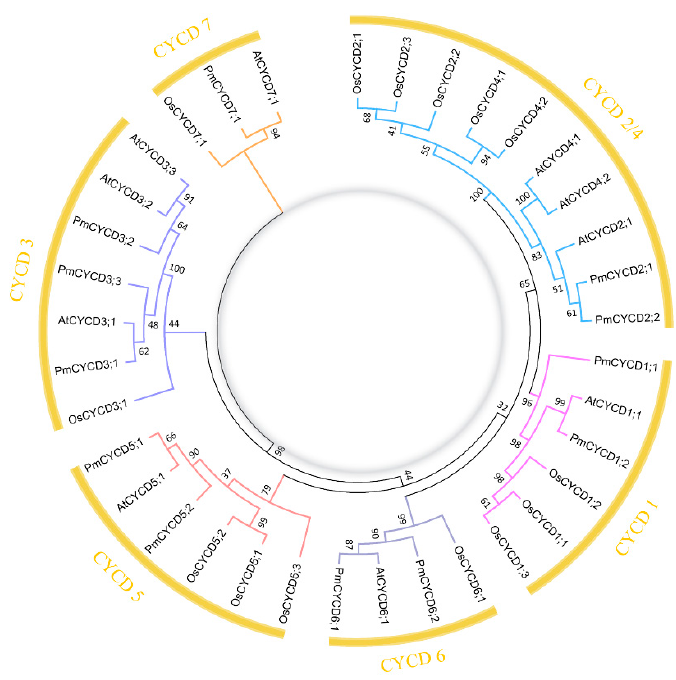
Figure 1. Phylogenetic tree analysis of P. mume CYCD ( PmCYCDs ) genes from P. mume , A. thaliana and rice. Multiple sequence alignments of full length sequences were performed and the ML tree was generated using MEGA 5.0 software. Each subgroup is distinguished in a different color.